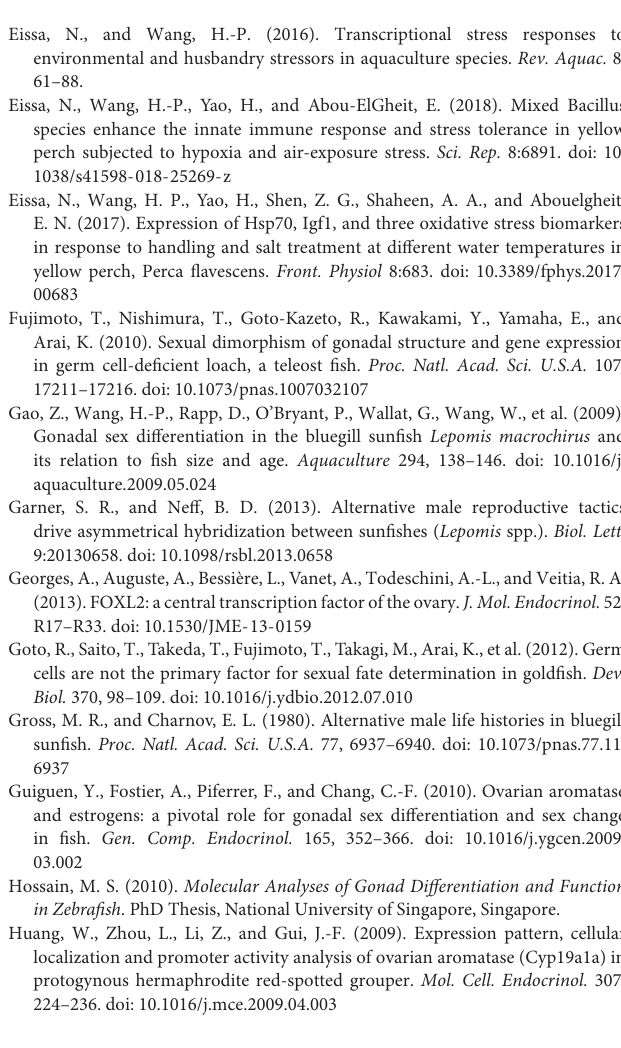
FIGURE S1 | Standard curves of foxl2 and 18S rRNA gene indicating a linear relationship between threshold cycle (CT) and gene copy number (concentration, copies µ L − 1 ). Eff %, PCR